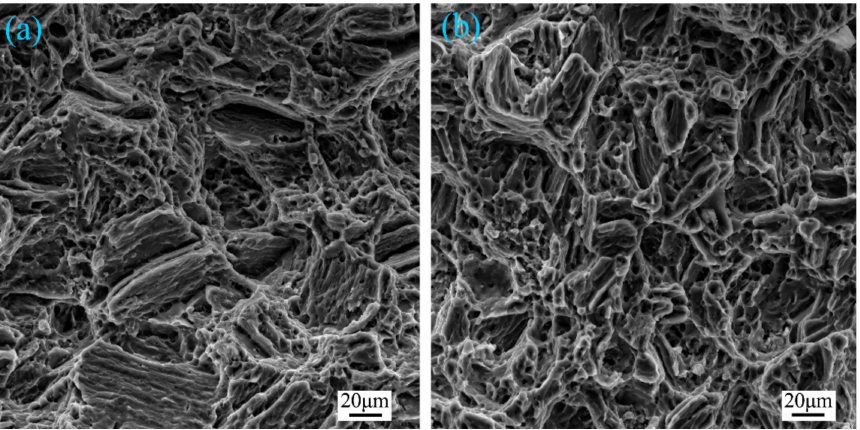
Figure 13. The typical fracture surfaces of the galvanized steel/AZ31B weldment: ( a ) a current of 65 A, ultrasonic power of 0 kW and ( b ) a current of 65 A, ultrasonic power of 0.9